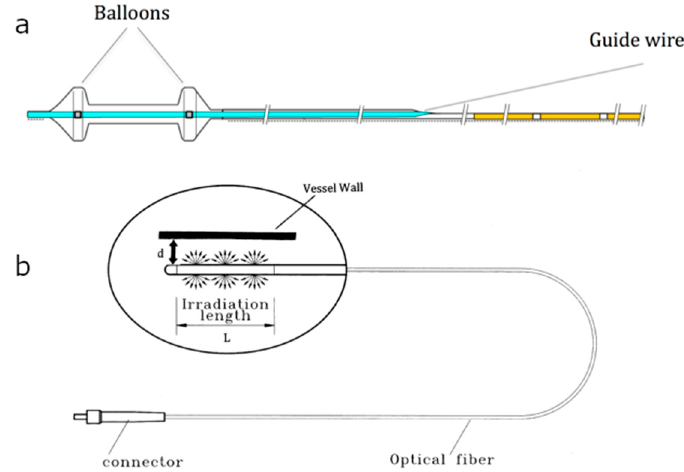
Figure 1. ( a ) Generic drawing of a stop-flow double balloon, multi-lumen nylon catheter (courtesy of Acrostak (Schweiz) AG); ( b ) generic drawing of a radial / cylindrical light diffuser for endovascular illumination (lower vessel wall omitted for clarity’s sake, courtesy of Medlight SA, Ecublens, Switzerland).